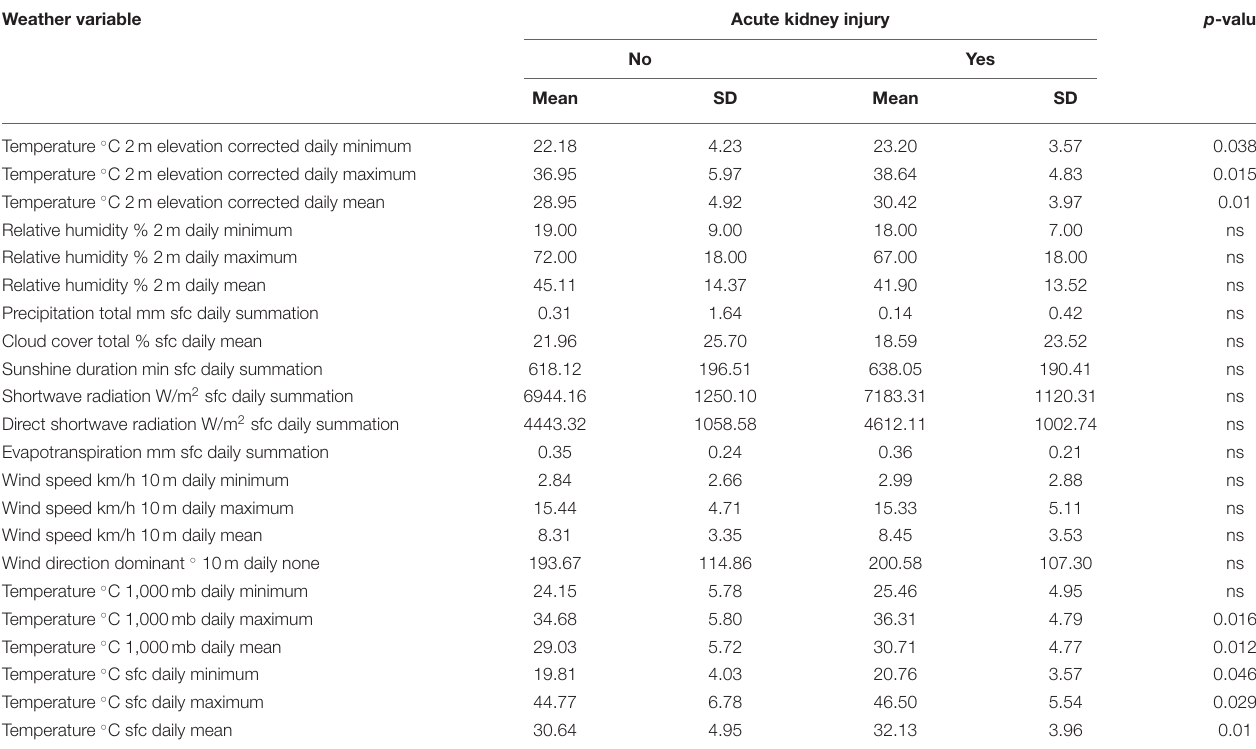
TABLE 3C | Difference in day-of-admission weather variables in Dubai City between COVID-19 patients’ clinical outcomes: Acute kidney injury. Weather variable